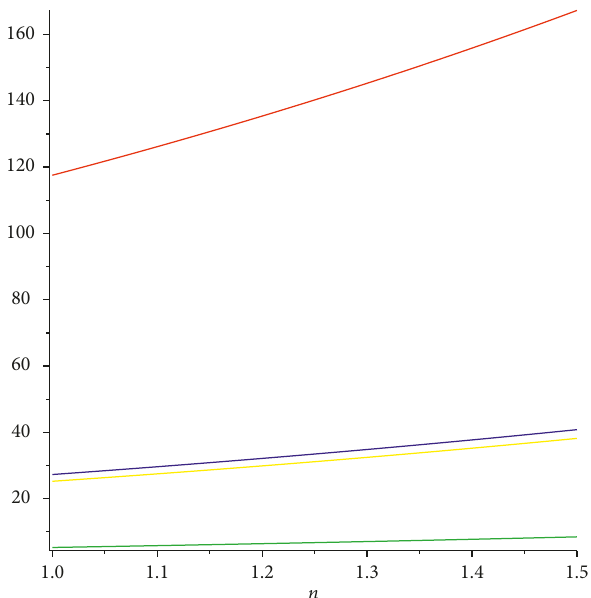
Figure 17: IRLF of D